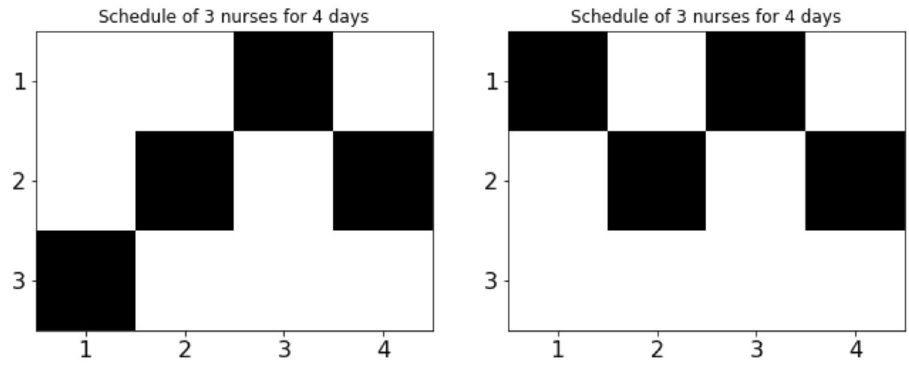
Figure 1. Graphical examples of the computed shift schedules for the case of = N 3 nurses for = D 4 days. A black square indicates that a nurse is scheduled to work. The horizontal axes labels the days and the vertical axes labels the nurses. The left figure represents a schedule that satisfies all the constraints, while the right figure represents a schedule that fails to satisfy the soft nurse constraint of every nurse being assigned some days of